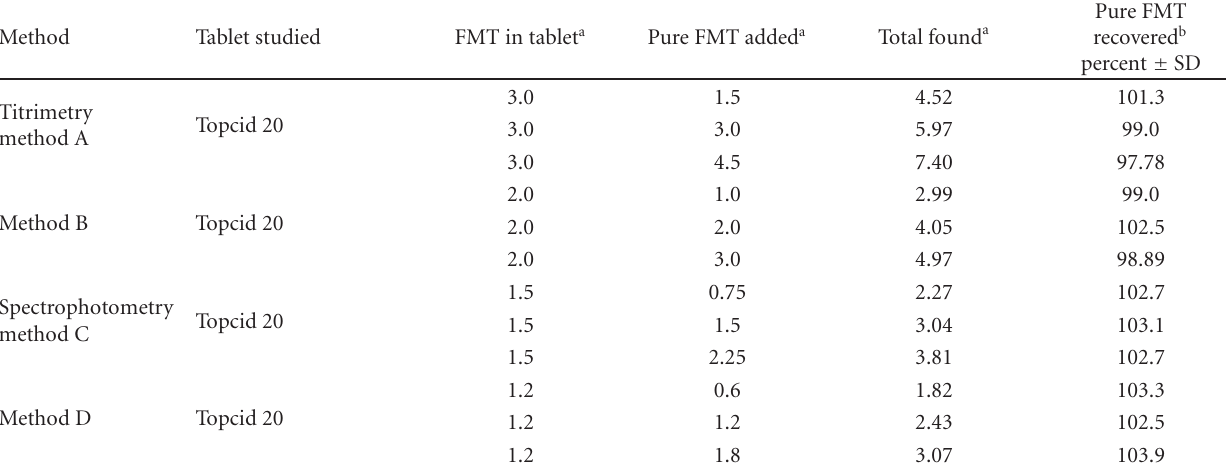
Table 6: Accuracy assessment by recovery